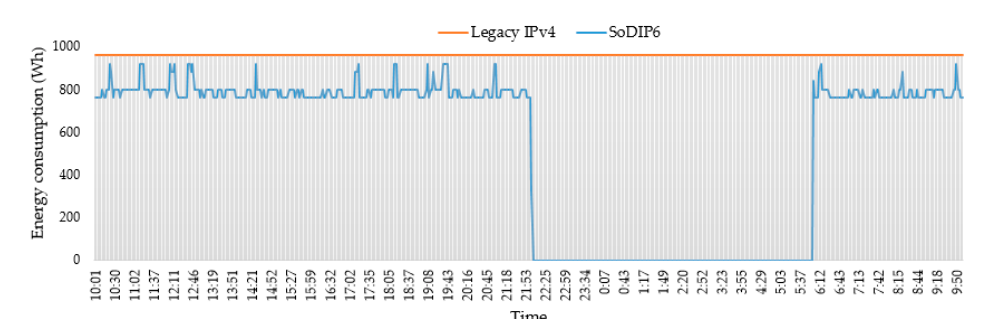
Figure 4. Pattern of total energy consumption by switches and customer premise equipment (CPE) in the legacy IPv4 and the software defined IPv6 (SoDIP6) network.